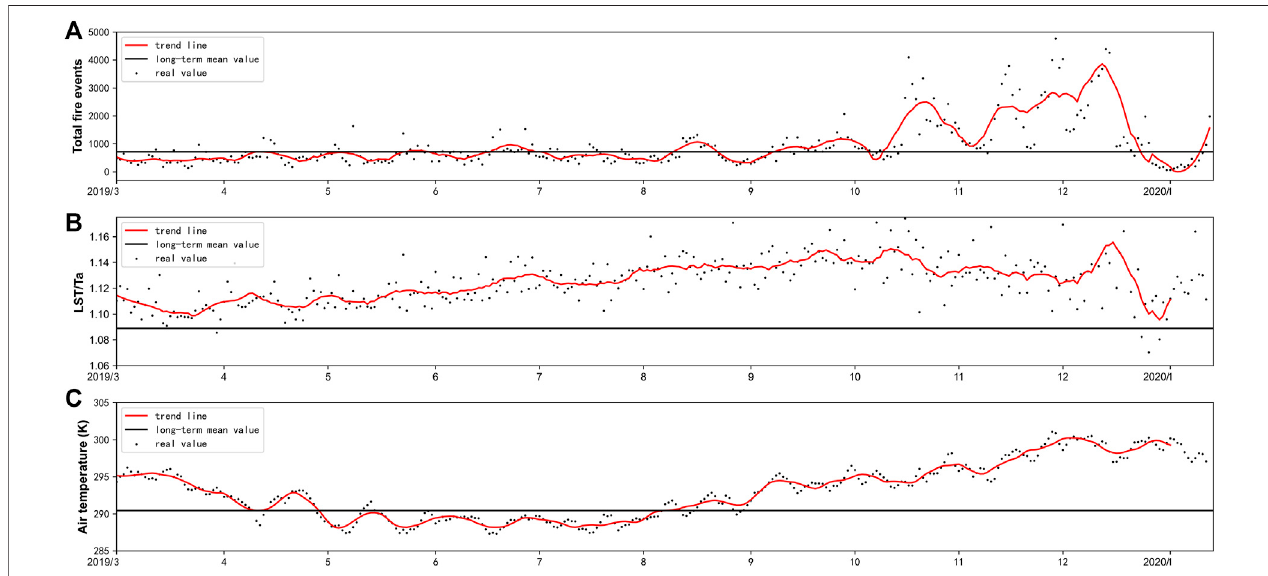
FIGURE 6 | Comparison of the difference in Australian daily total fi re events curve (A) , LST/Ta curve (B) and air temperature (C) . The long-term mean values that represent the typical year state are indicated by the black line, and the trend value is indicated by the red curve.